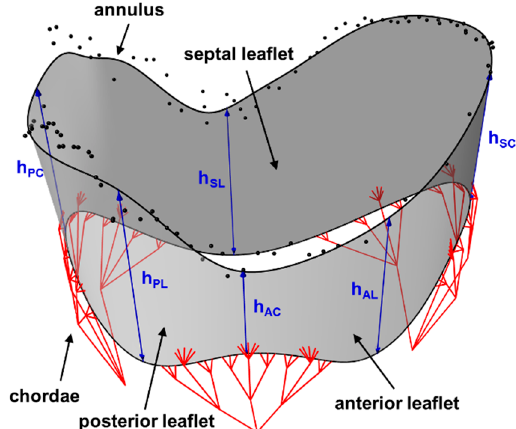
Figure 12. Parametric definition of a B-spline TV surface and chordae. Each leaflet and commissure height is indicated as h , where the subscript S, P, or A denotes the septal, posterior, or anterior leaflet, and C or L denotes a commissure or a leaflet location.